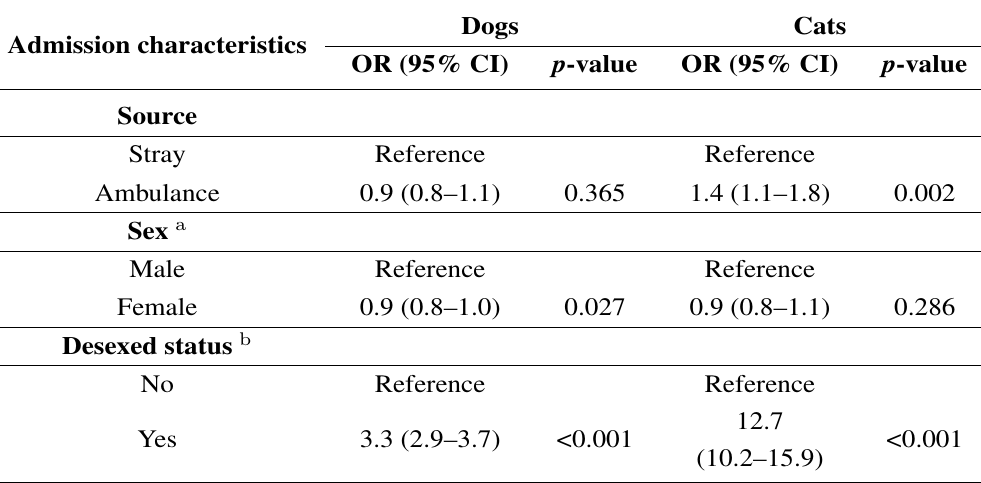
Table 3. Results of a multivariate logistic regression model describing the odds ratios for presence of a microchip in stray adult dogs and cats admitted to RSPCA-QLD shelters (January 2012–December